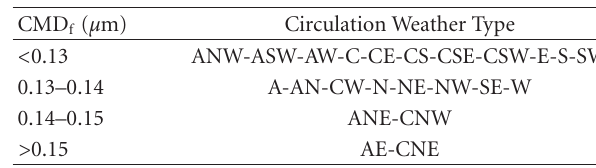
Table 5: Count median diameter of the fine or accumulation mode (CMD f ) for each Circulation Weather